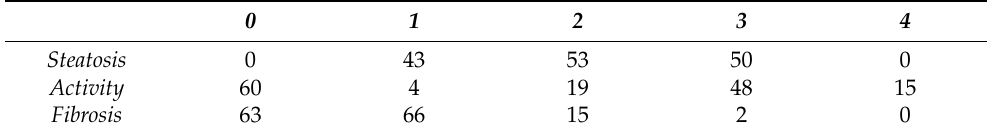
Table 1. Histopathological characteristics. SAF score.